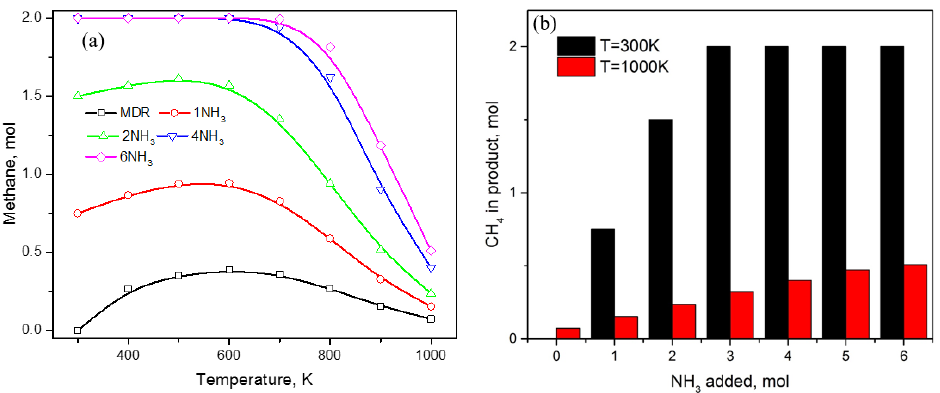
Figure 4. ( a ) Effect of ammonia content in MDR on methane; ( b ) comparison in methane amount in presence of NH 3 at 300 K and 1000 K with regard to no NH 3 in